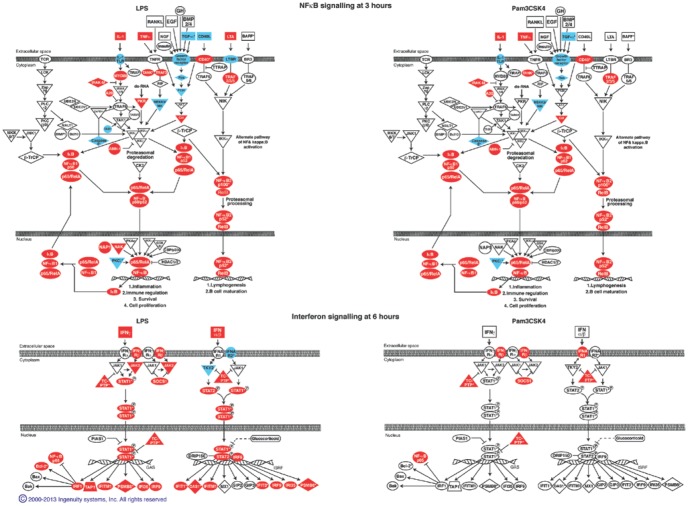
NFκB and Interferon signalling pathways.Shown at the peak of their significance, 3 and 6 hours respectively. Significantly expressed genes within the pathway (from Pam3CSK4 1202 and LPS 4777 lists) shaded red if upregulated or blue if down regulated.